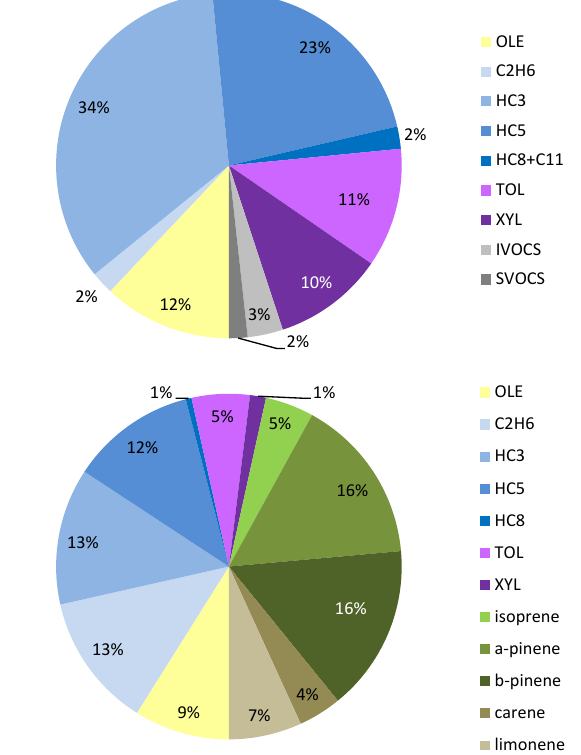
Figure 1. Precursor NMHC mass distributions for the outflow sim- ulation runs. (a) Urban case emissions by mass. Total emissions are 2.6gm − 2 d − 1 . Species classes correspond loosely to those of the RACM mechanism (Stockwell et al., 1997) and the volatility-based nomenclature of Donahue et al. (2009). “OLE”, olefins; “C2H6”, ethane; “HC3”, propane and similar species; “HC5”, n -pentane and similar species; “HC8 + C11”, n -alkanes with 8 to 11 carbons, and cyclohexane; “TOL”, toluene, benzene, and ethyl benzene; “XYL”, xylenes, trimethyl benzenes, and ethyl toluene; “IVOCS”, n -alkanes with 12 to 17 carbons; “SVOCS”, n -alkanes with 18 to 30 carbons. Branched alkanes constitute 16 and 66% of the mass in classes “HC3” and “HC5”, respectively. (b) Forest case precursor inputs. Species classes are as in (a) . Inputs shown total 0.23gm − 2 d − 1 . In- puts of oxygenated C1–4 species are omitted for clarity, and com- prise an additional 0.7gm − 2 d − 1 including 0.2gm − 2 d − 1 from methyl vinyl ketone and methyl butenol,